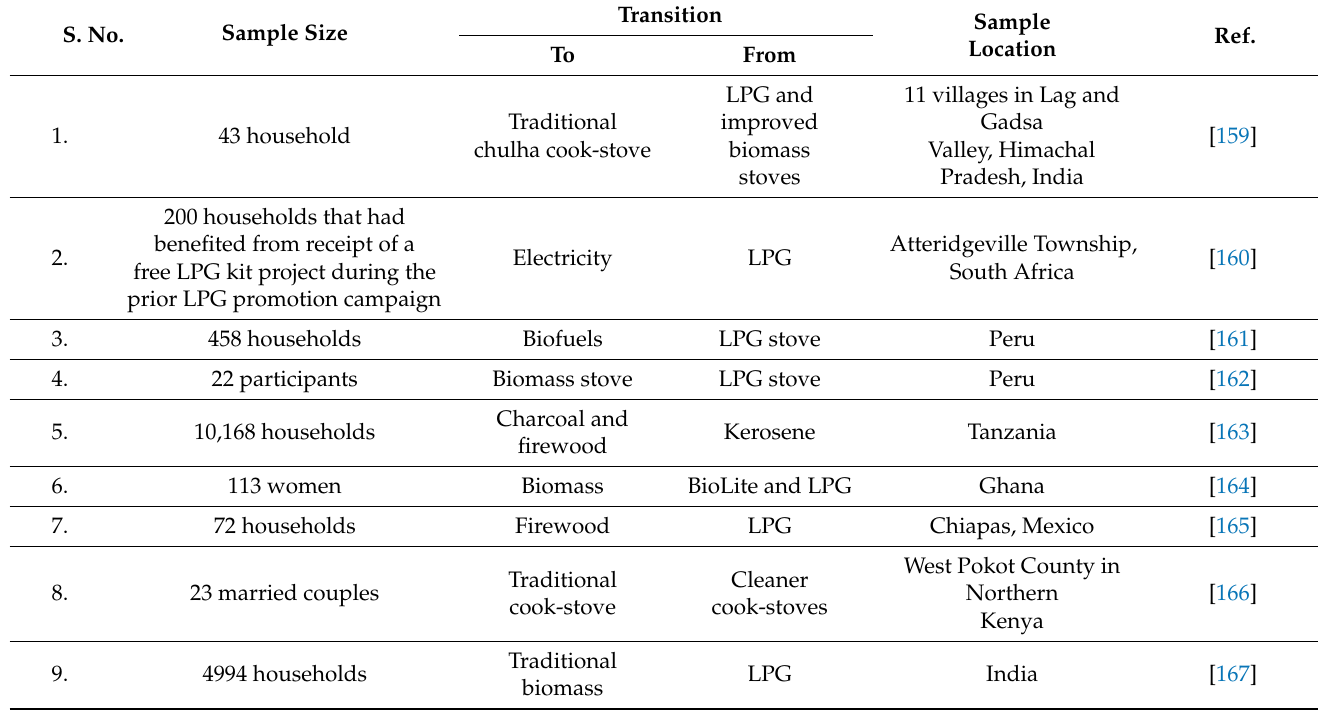
Table 7. Summary of literature on adoption of improved cook-stoves of gaseous and liquid fuels.